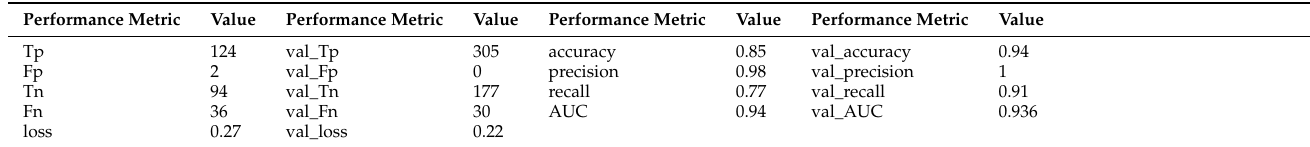
Figure 13. Confusion matrix for the proposed IMG-CNN model. Table 8. Evaluation metrics for the IMG-CNN